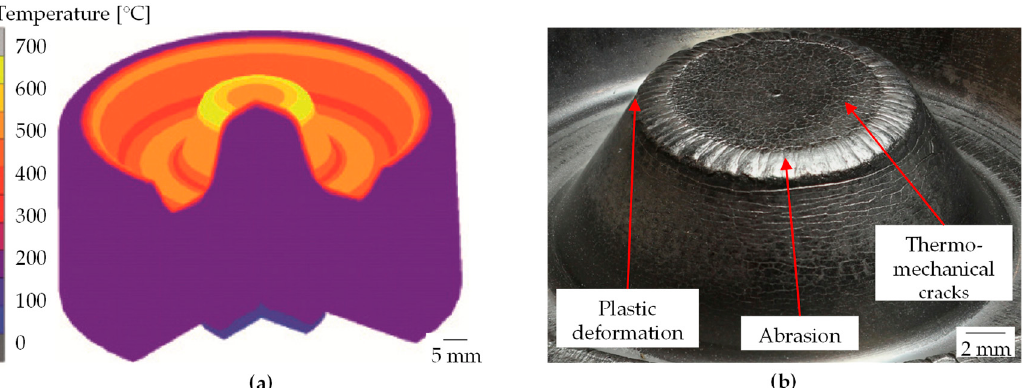
Figure 1. Primary thermal loaded forging die: ( a ) temperature distribution in the die after one stroke [7]; ( b ) signs of wear at the mandrel after 1000 strokes (adapted with permission from Ref. [8]. 2021, Kai Brunotte).